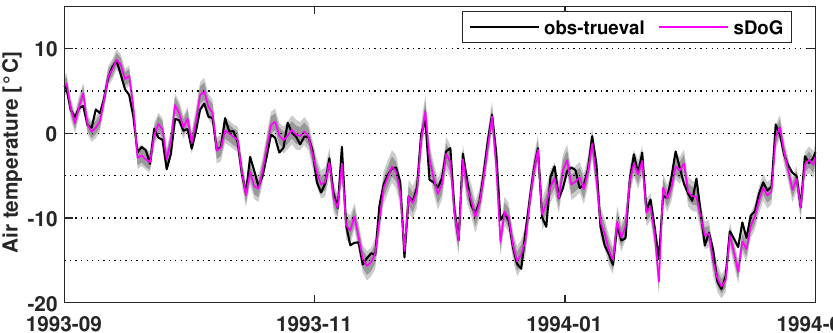
Figure 2. Snapshot of daily air temperature at VERNAGT in the evaluation period: observations (obs-trueval, black), and the sDoG retrospective forecast (magenta) along with uncertainties; dark and light grey shadings are the one and two standard errors (1SE and 2SE).